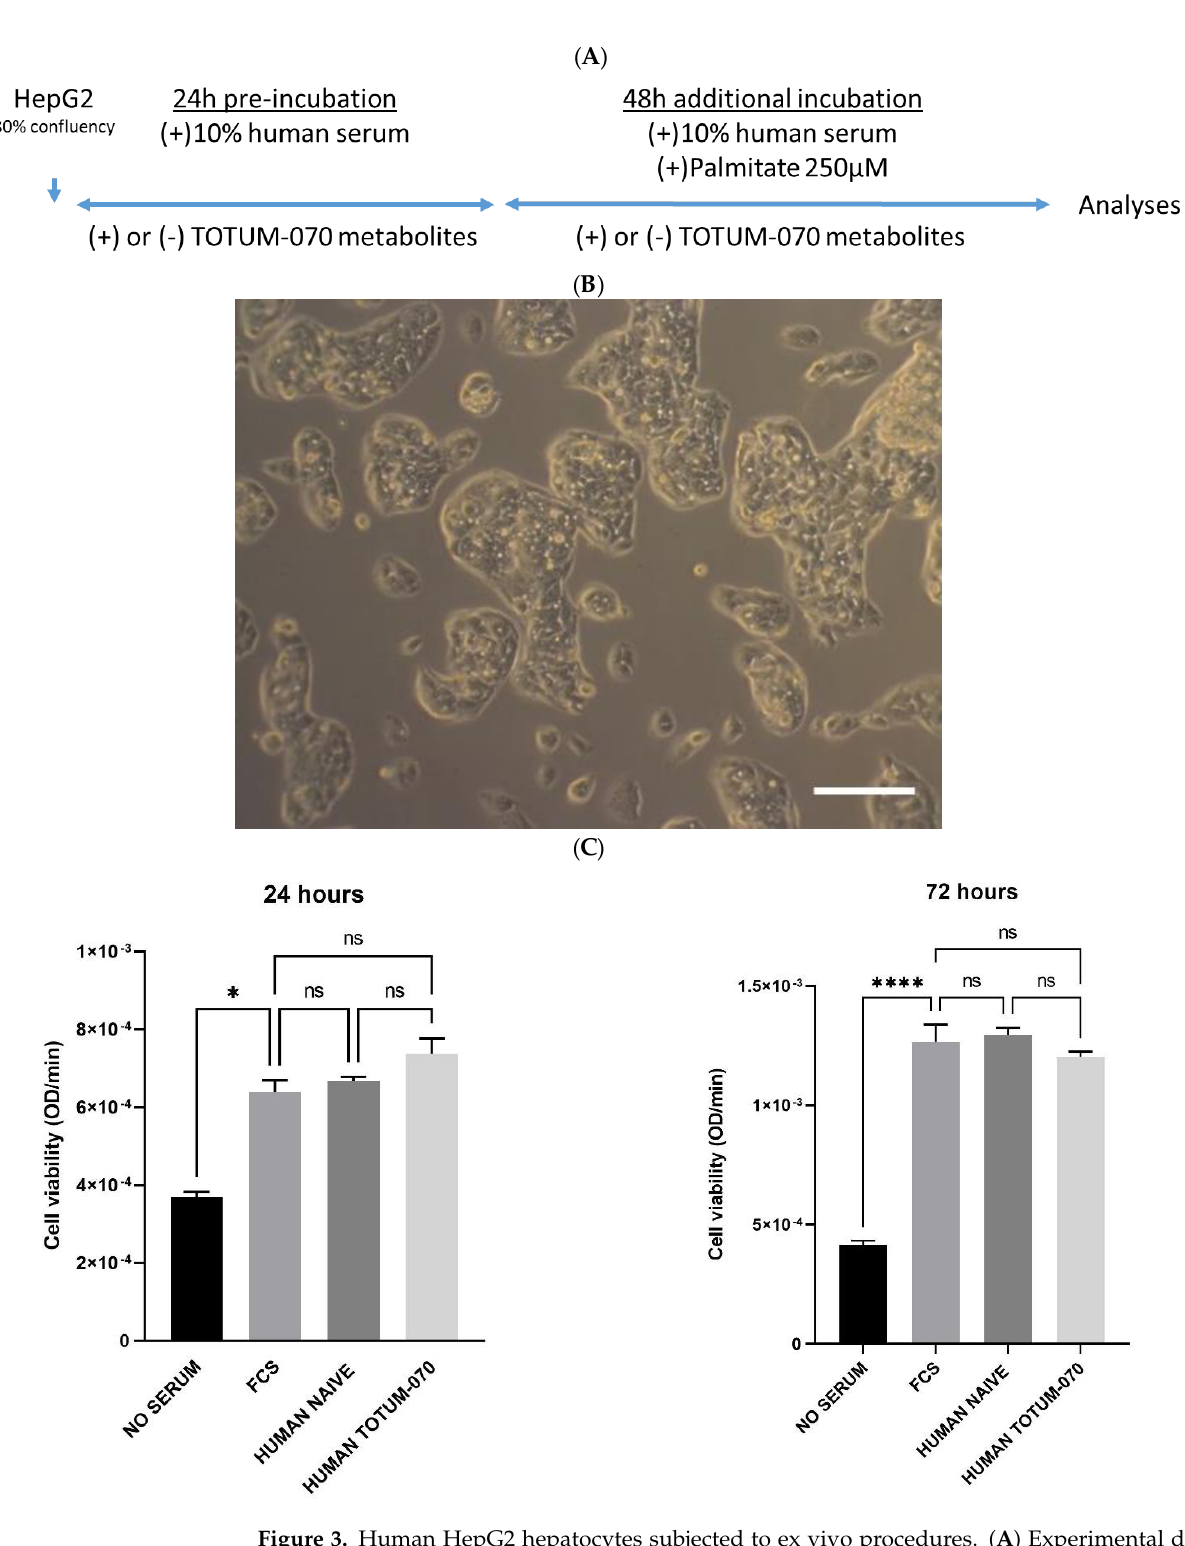
Figure 3. Human HepG2 hepatocytes subjected to ex vivo procedures. ( A ) Experimental design. ( B ) Phase contrast microscopy of human HepG2 hepatocytes. ( C ) Cell viability measured by XTT-based assay. Measures were performed in quadruplicates per condition/volunteer ( n = 10 volunteers). Values are presented as the means ± SEM unless specified otherwise. The differences were considered statistically significant at p < 0.05 with * for p < 0.05; **** for p < 0.0001 and ns for p > 0.05. Cell viability 24 h (global p -value < 0.0001; F value = 10.44); 72 h (global p -value < 0.0001; F value = 69.82). Scale bar, 100 µm.